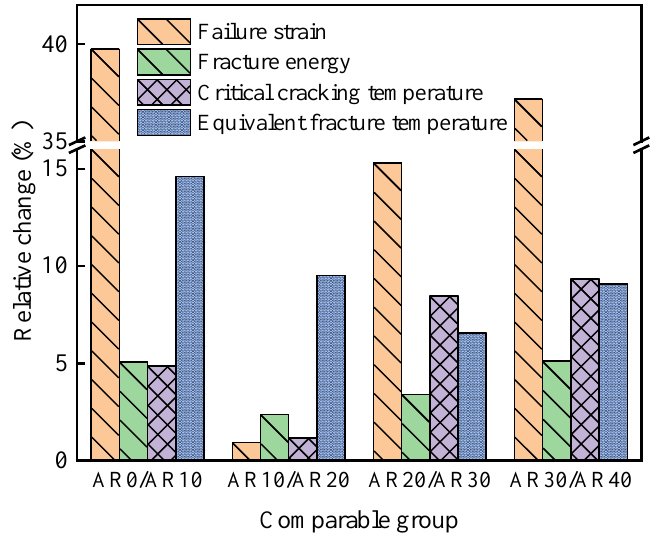
Figure 9. Relative change in different indices.